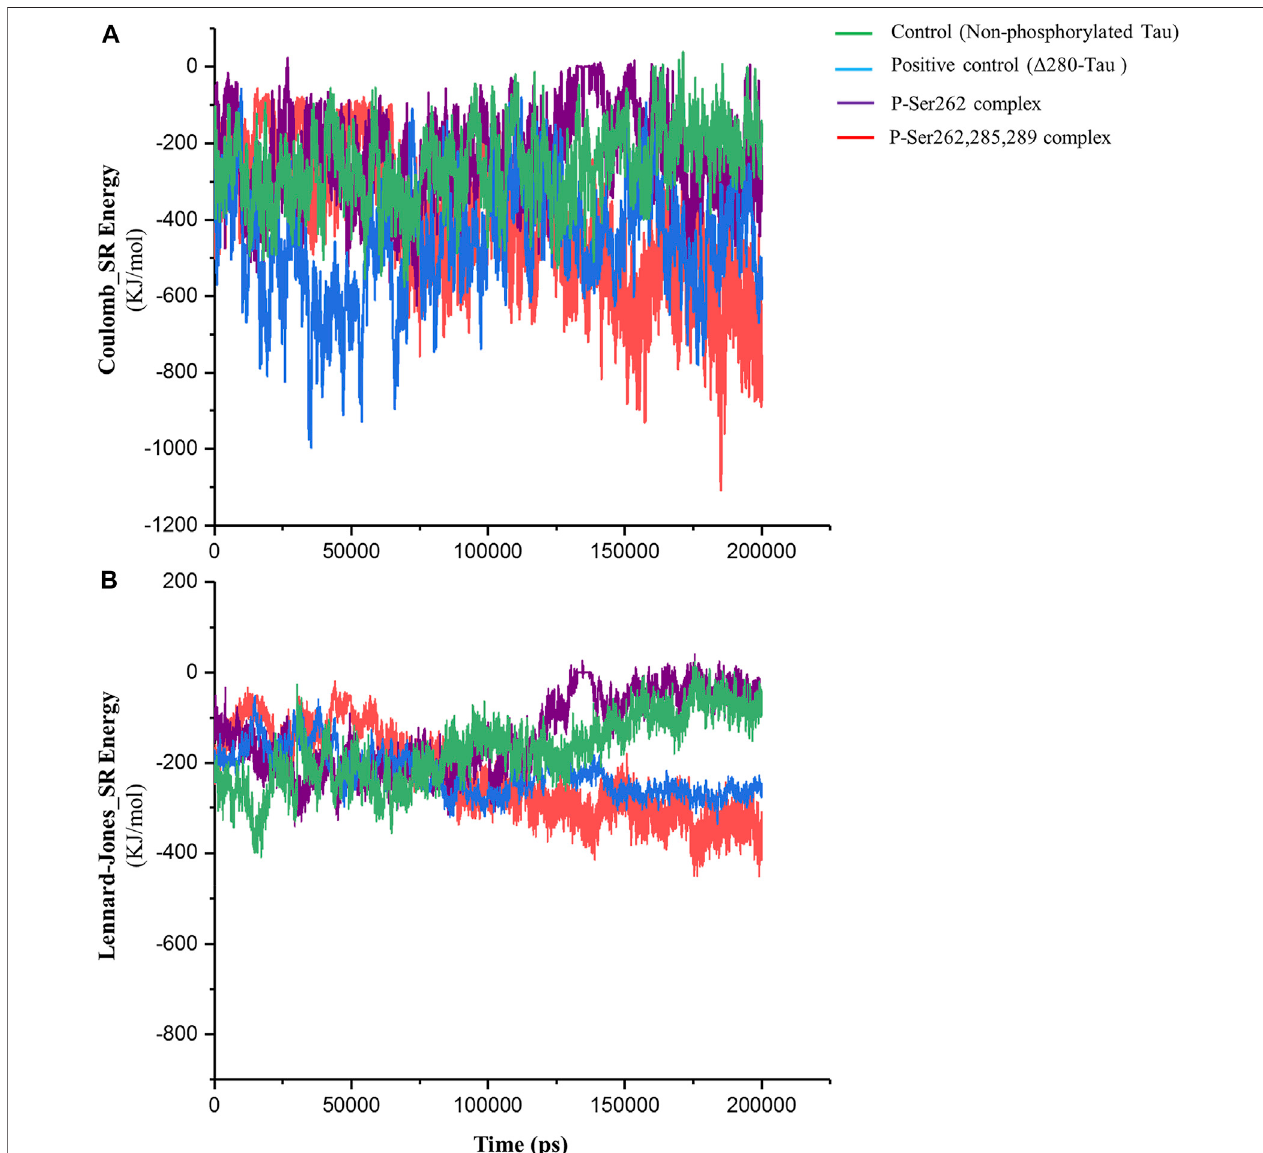
FIGURE 3 | Short-range Coulomb and Lennard-Jones energies between two segments in the control (non-phosphorylated tau), positive control ( Δ 280-tau), and the complexes with one (P-Ser262) and three (P-Ser262, 285, and 289) phosphorylated sites during 200 ns simulations. (A) Coulomb and (B) Lennard-Jones energies are more negative in P-Ser262, 285, and 289 compared to